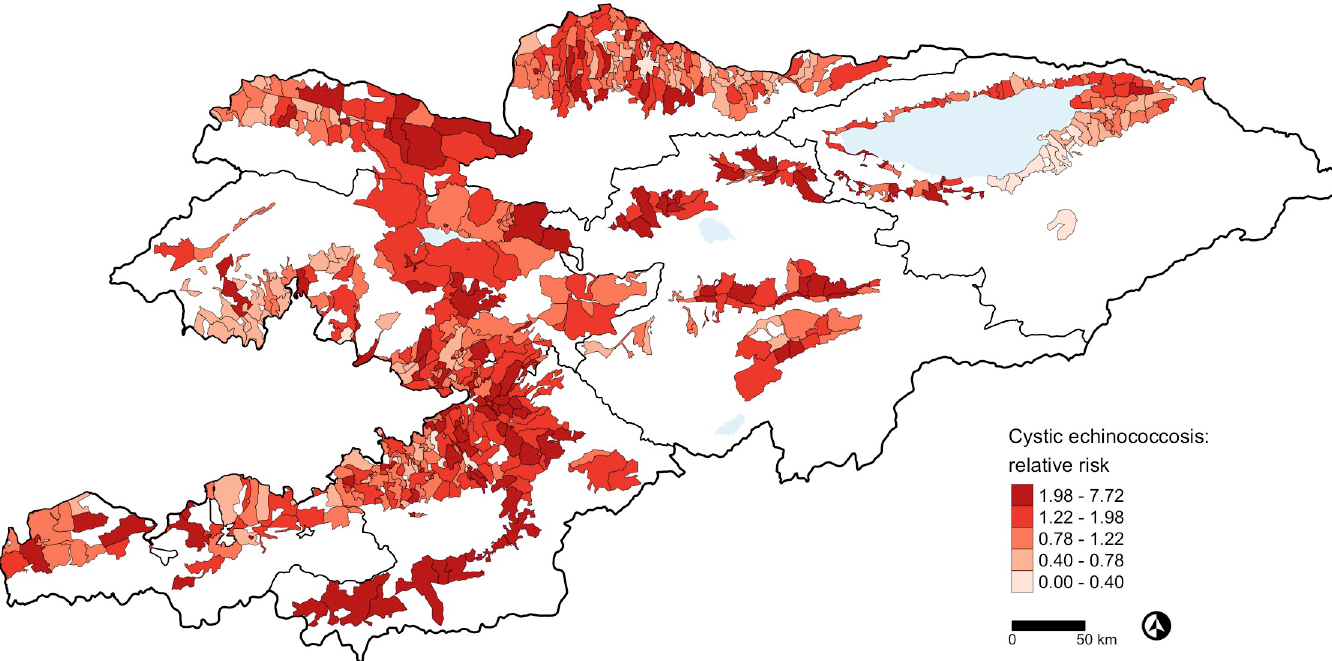
Fig 1. Estimated relative risk based on the Besag, York and Mollie´ model for cystic echinococcosis in Kyrgyzstan, 2014-2016. The local administrative units of Kyrgyzstan cover only the settlements and their surroundings. The white spaces are unsettled areas that do not fall within any local administrative unit. We used the third level administrative boundaries of Kyrgyzstan as provided by REACH, a joint initiative of IMPACT, ACTED, and the UN Operational Satellite Applications Programme (UNOSAT) under a humanitarian license. The shapefiles were subsequently edited to add missing polygons. The code and files for the map are available at: https://git. math.uzh.ch/reinhard.furrer/Echin_kgz. Shape files for third level administrative regions are now freely available from the United Nations Office for the Coordination of Humanitarian Affairs https://data.humdata.org/dataset/kyrgyzstan-administrative-boundaries.